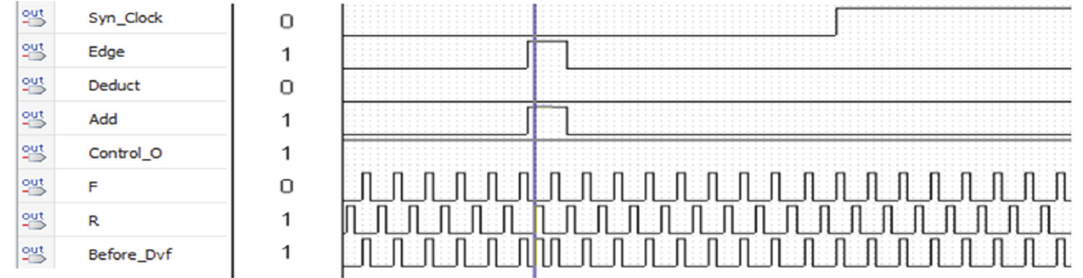
Figure 10: Simulation results of control module in phase lag.